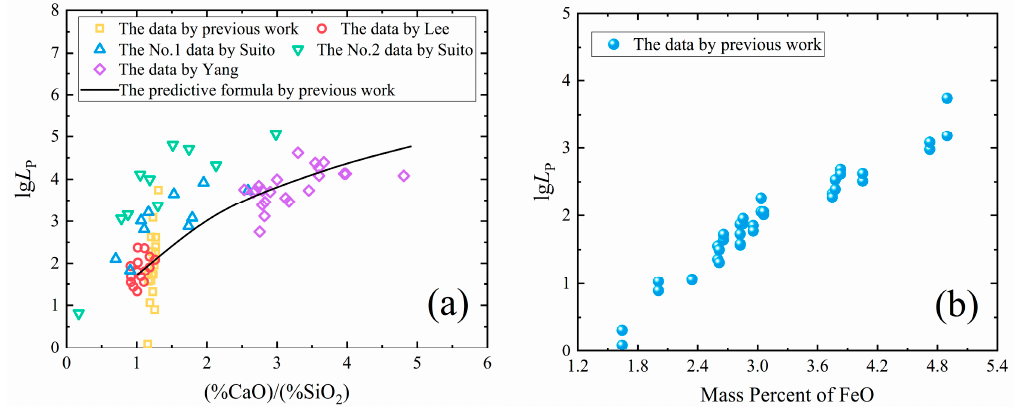
Figure 5. The relationship between lg L P and slag: ( a ) the basicity (%CaO) / (%SiO 2 ) and ( b ) the mass percent of FeO [19].